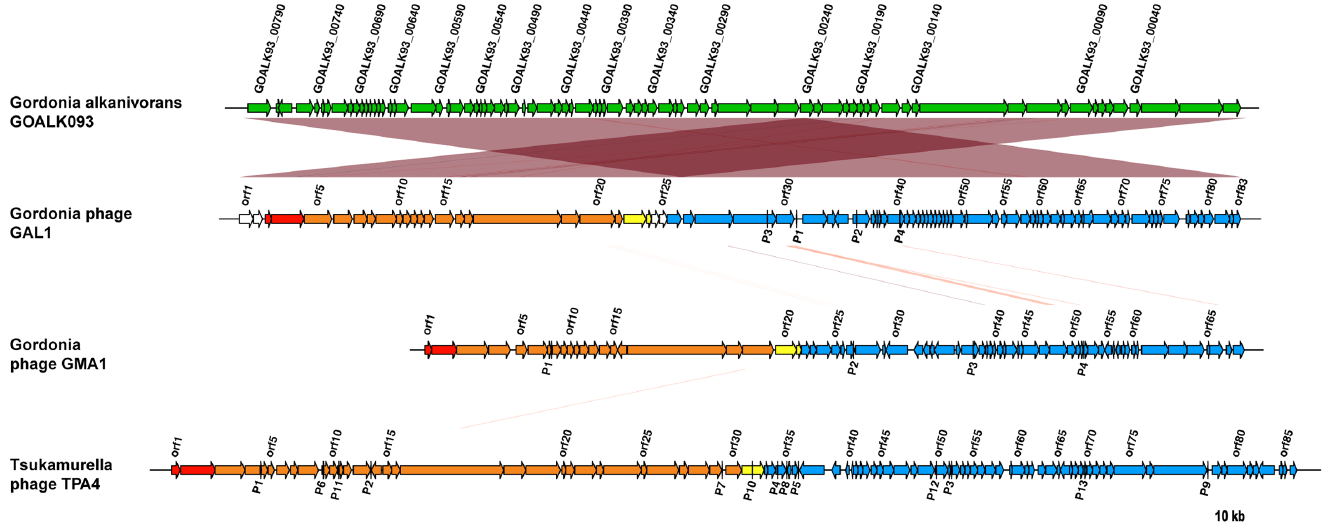
Fig 2. Genome maps of temperate Mycolata phages GAL1, GMA1, and TPA4 and the predicted prophage GOALK093 from the genomes of G . alkanivorans . The arrows represent the annotated gene and direction of transcription in each genome. Gene modules are similarly shaded i.e., red = encodes DNA packaging proteins, orange = encodes structural proteins, yellow = encodes lysis proteins, blue = encodes phage maintenance proteins. The genome not annotated in this study is shaded in green. Regions of homology are also indicated.